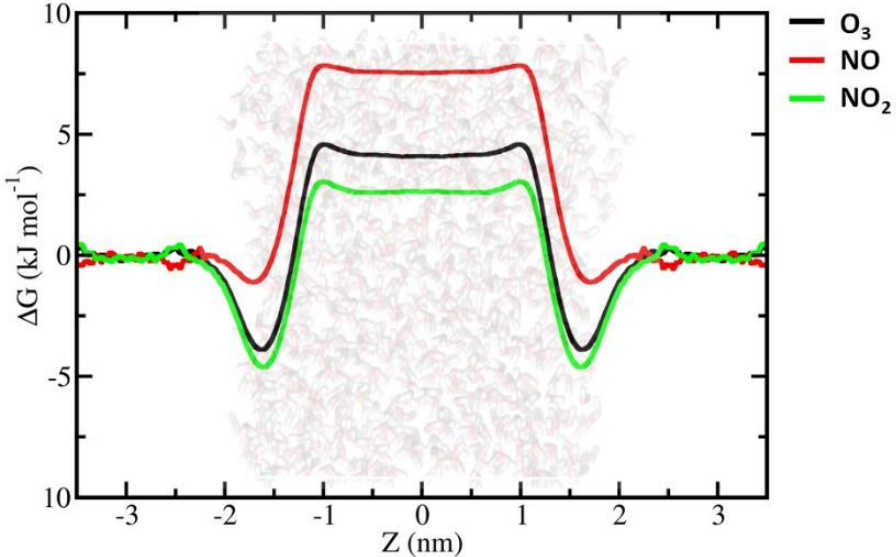
Figure 4. FEPs of the hydrophobic RONS were obtained by US simulations by calculation of the WHAM method.